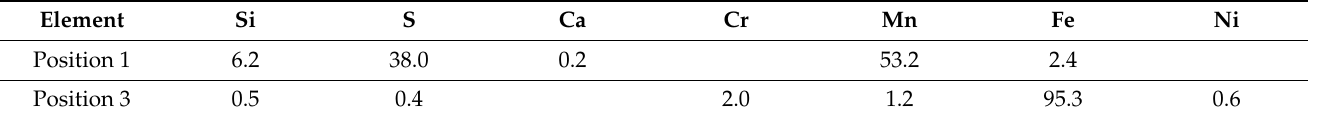
Table 8. Element percentage (wt. %) measured at positions in Figure 18a.